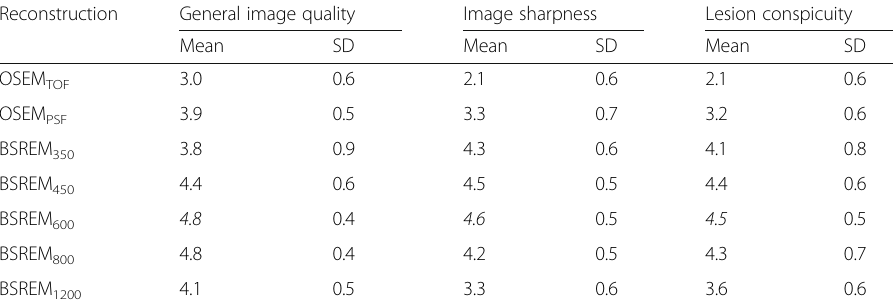
Table 2 Results of subjective PET image quality ratings for different reconstruction algorithms. Italicized numbers are the reconstructed datasets yielding the highest score for each assessed